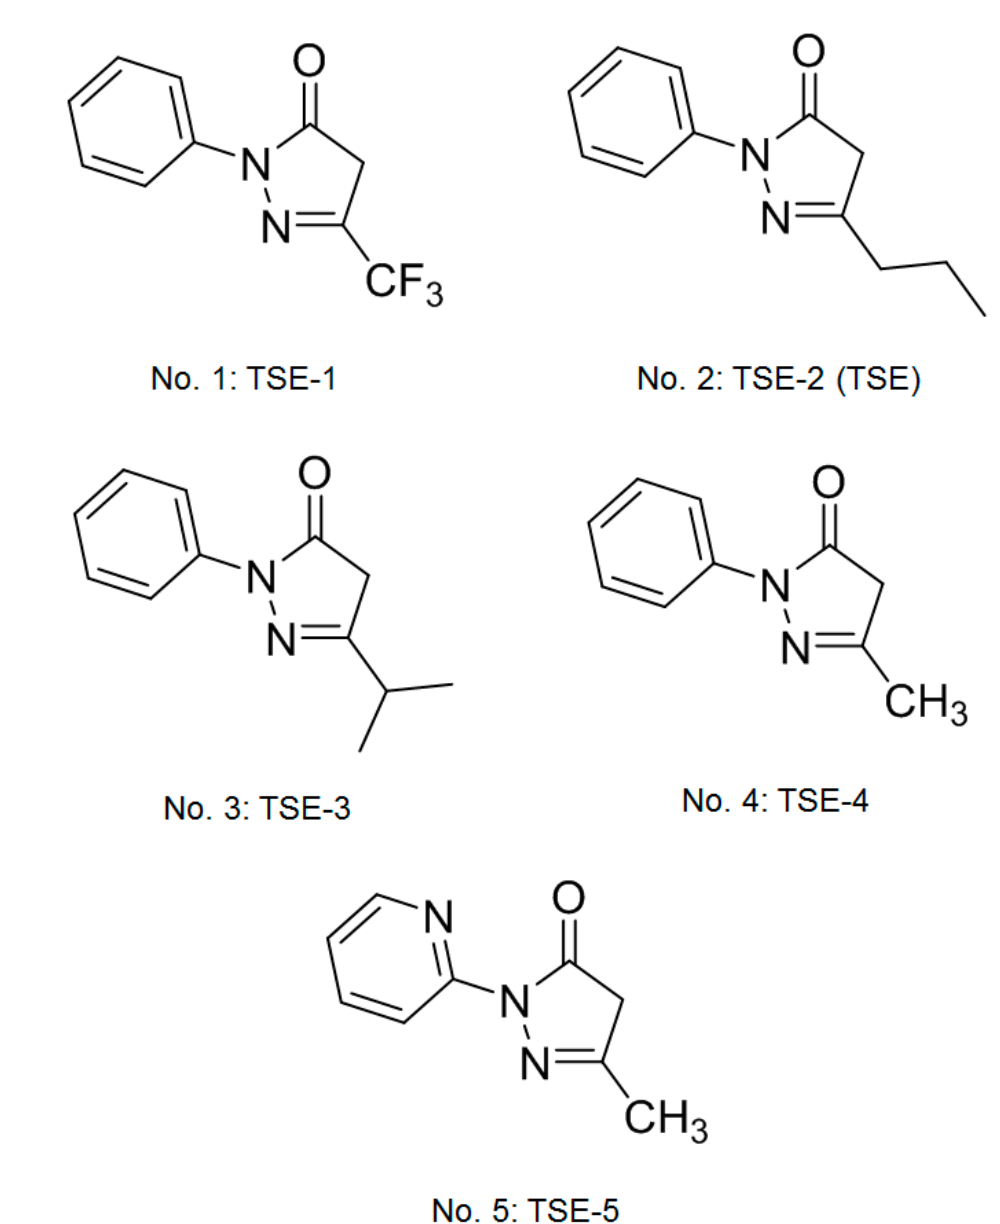
Figure 1. The chemical structure of five compounds of 2,4-dihydro-3H-pyrazol-3-one (DHPO) de-